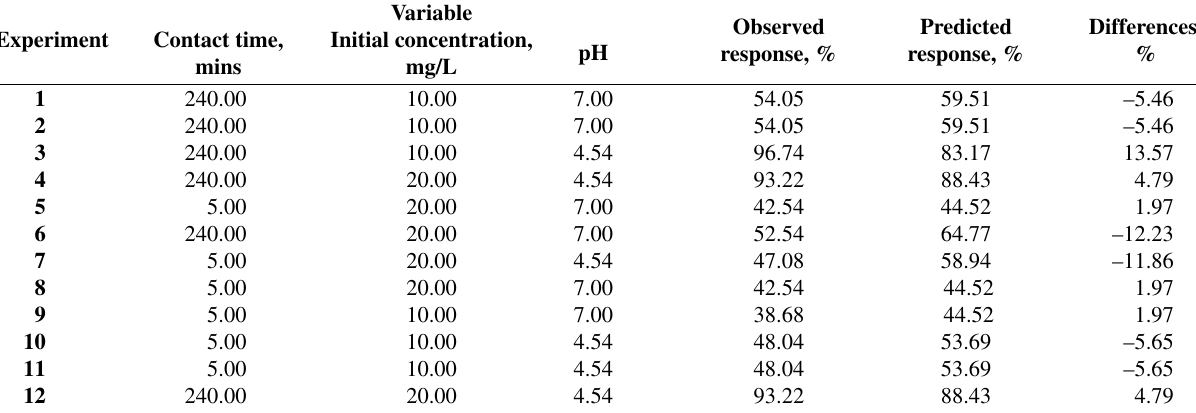
Table 3. Plackett-Burman design and results for the percentage removal of MG in binary dye